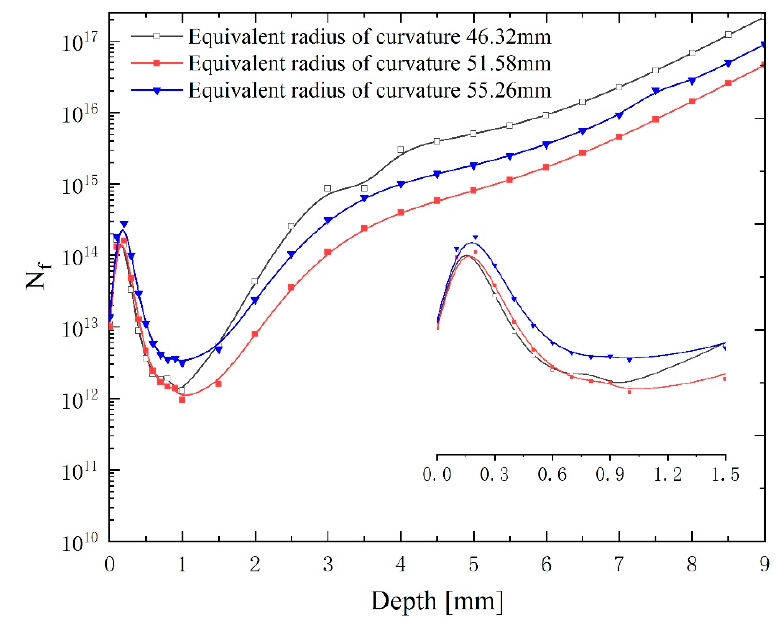
Figure 16. Influence of radius of curvature on life.